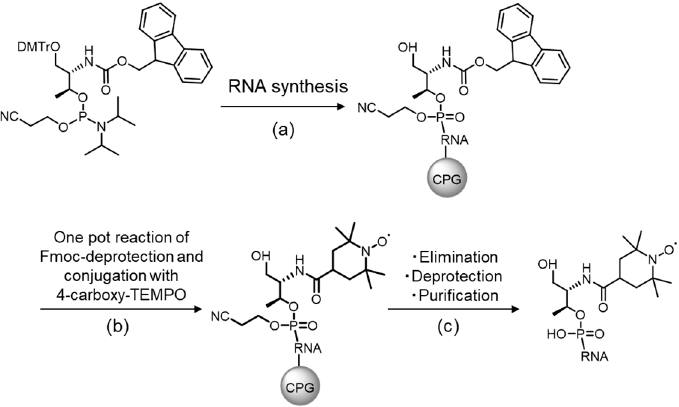
Figure 4. Scheme showing introduction of the (2,2,6,6-tetramethylpiperidin-1-yl)oxyl (TEMPO) moiety following solid-phase synthesis of RNA. ( a ) An Fmoc-protected D-threoninol was incorporated during solid-phase synthesis of RNA. ( b ) Deprotection of Fmoc and coupling of 4-carboxy-TEMPO was carried out simultaneously. RNA-conjugated controlled pore glass (CPG) was dispersed in dimethylformamide (DMF) and incubated with 4-carboxy-TEMPO (100 eq., TCI), 1-ethyl-3-(3-dimethylaminopropyl)carbodiimide (EDC) (250 eq.), hydroxybenzotriazole (HOBt) (250 eq.), and triethylamine (2.8 eq.) at 40 °C for 12–24 h. ( c ) The removal of RNA from CPG and deprotections were performed using conventional methods. The RNA was purified by reverse-phase high-performance liquid chromatography (HPLC).